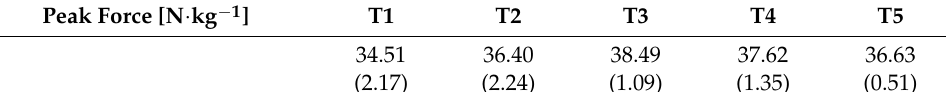
Figure 1. Peak force from the IMTP test.